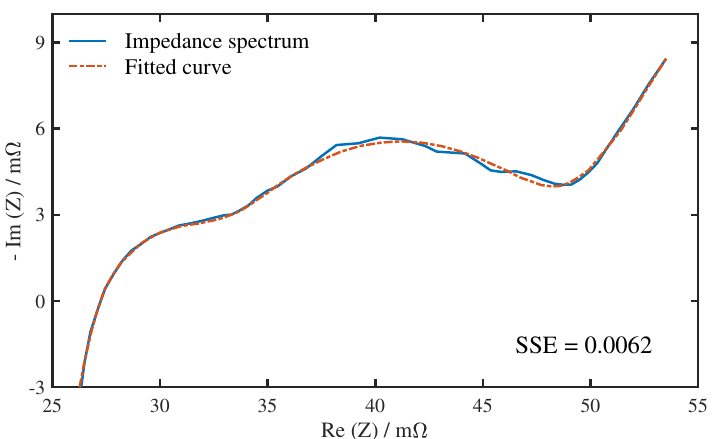
Figure 5. The impedance fitting based on the second-order equivalent circuit model, after 250 cycles of life test under 45 ◦ C@0.5–1 C condition and EIS measured at 20% SoC with 500 mA